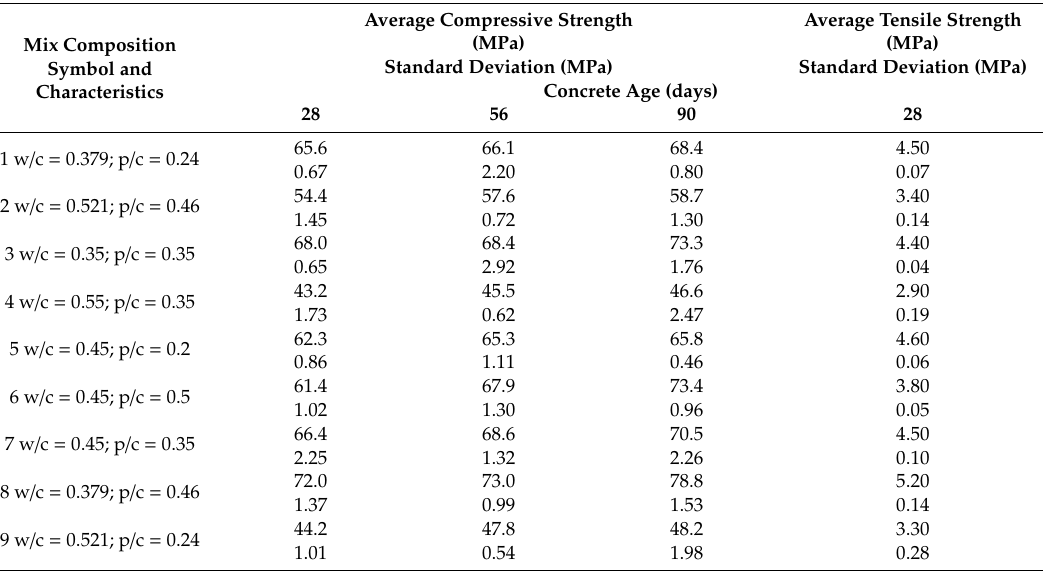
Table 7. Compressive and tensile strength results.